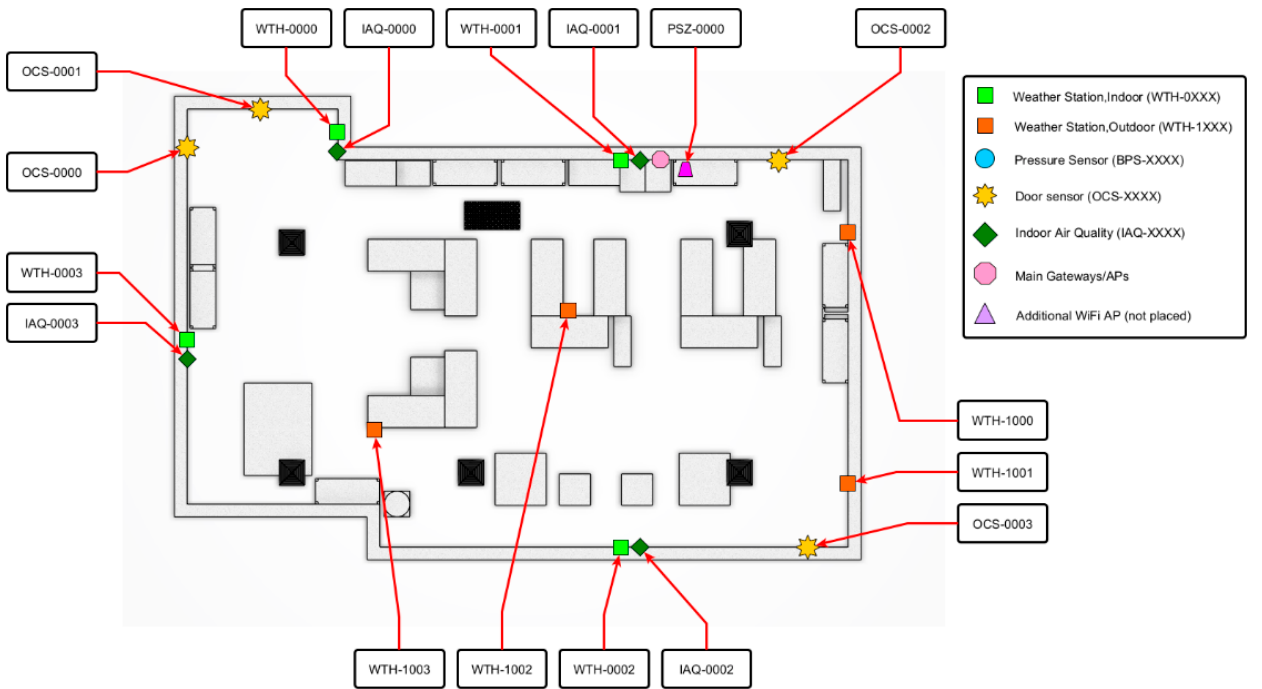
Figure A8. Sensor placement for the hospital ward.